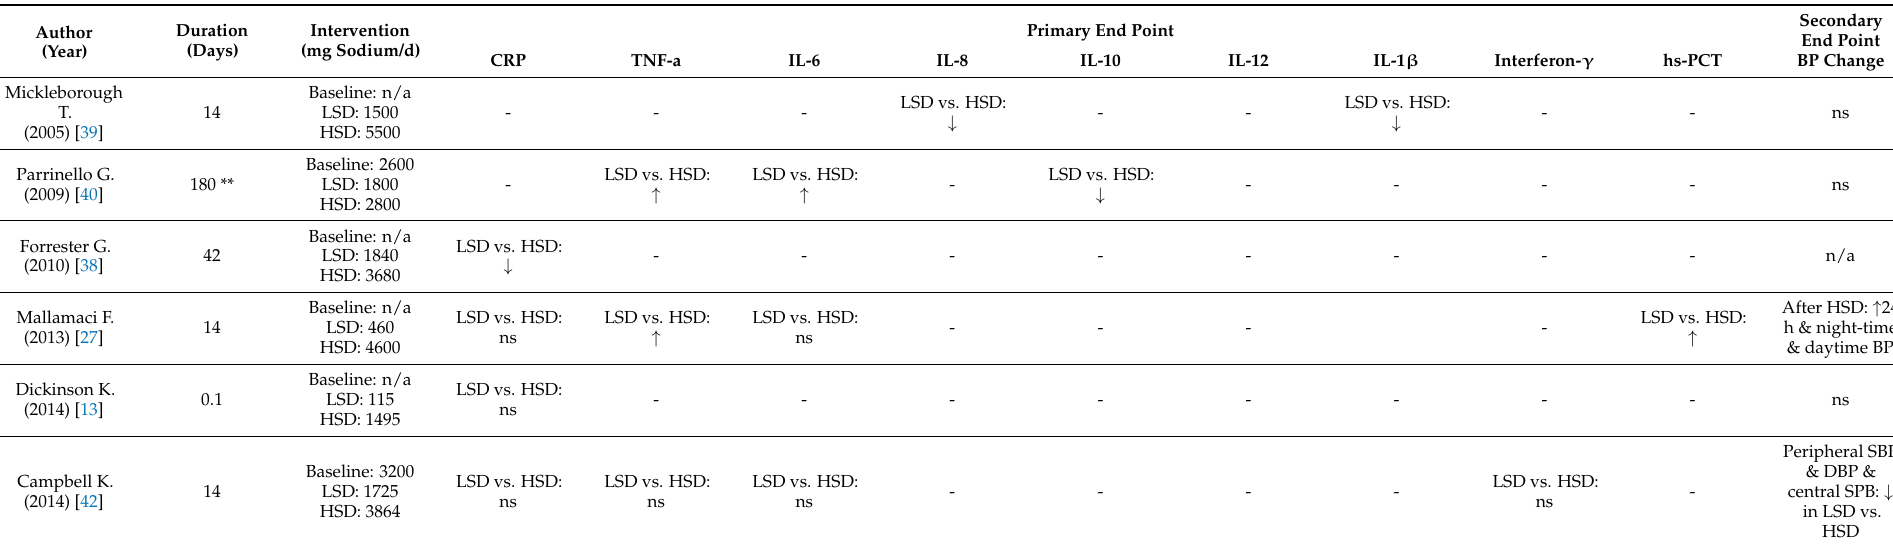
Table 2. Brief qualitative description of results, primary and secondary end points, per study ( n =